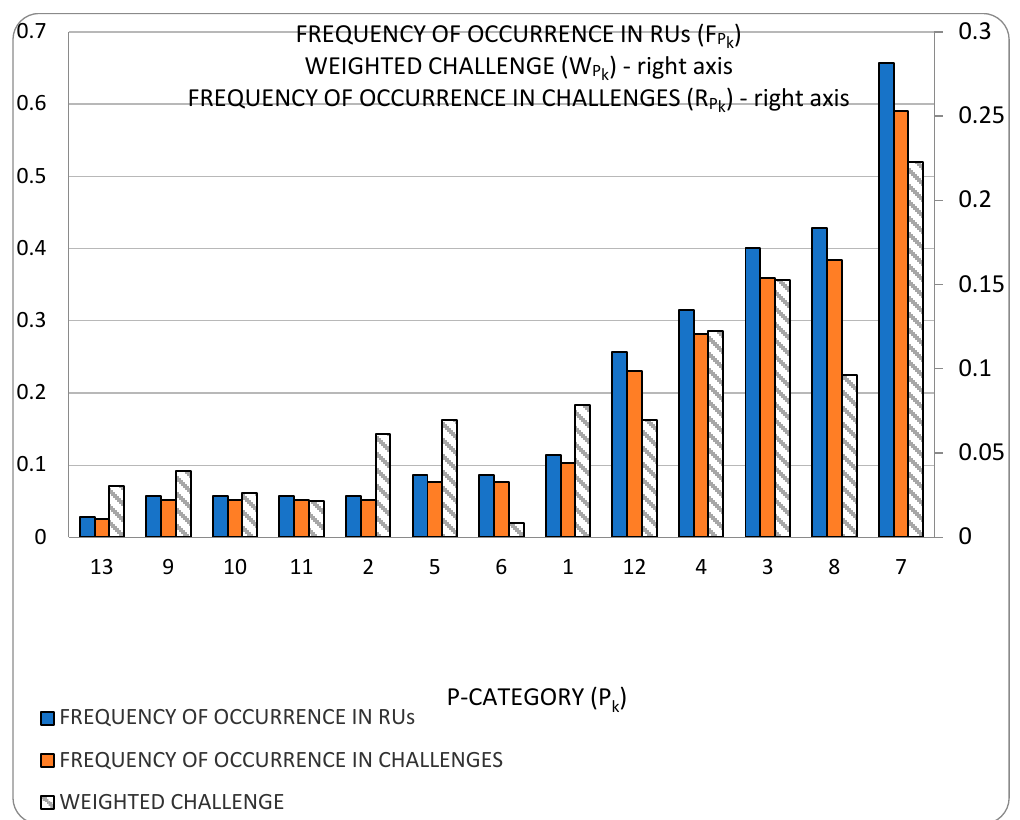
Figure 20. Frequency, Research Interest and weighted Challenge bar chart.